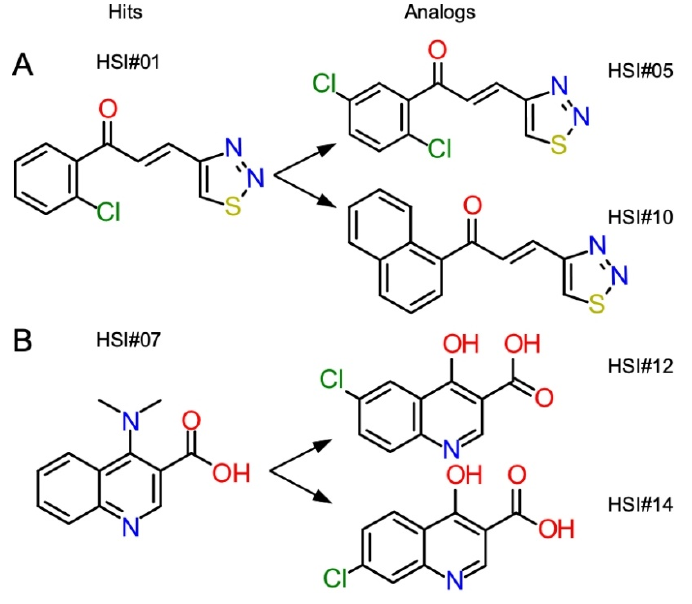
Figure 6. Compound structures of HSI#1, 5, and 10 ( A ) and HSI #7, 12 and 14 ( B